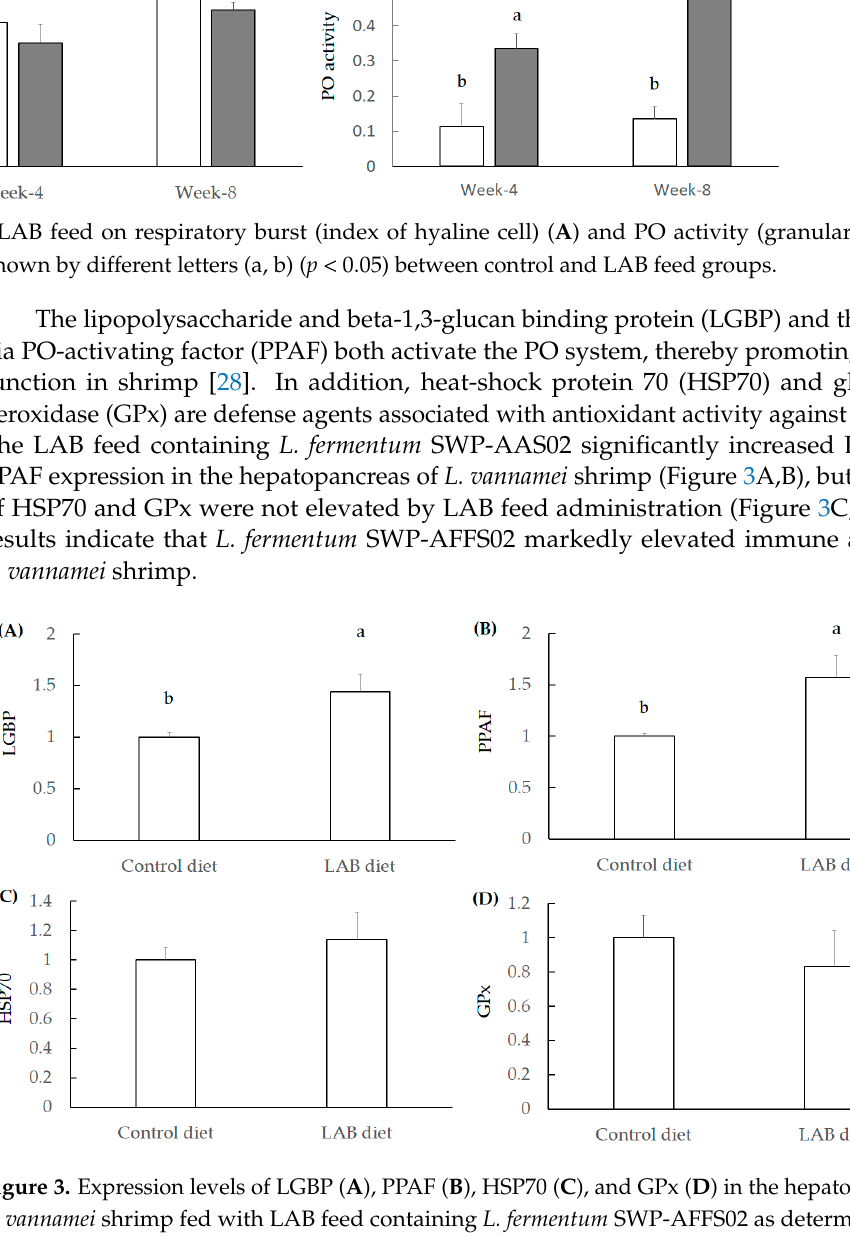
Figure 4. Alpha and Beta diversity of intestinal microbiota in L. vannamei shrimp. ( A ) Venn diagram. The overlapping part indicates the number of OTUs shared between control and LAB treatment groups, and the non-overlapping part indicates the number of unique OTUs between two groups. ( B ) Principal component analysis (PCA) for species. Each point in the figure represents one sample, and the same grouped samples are represented by the same color. We analyzed the most abundant microbes (top 35) at the genus and family levels in the stool of L. vannamei shrimp fed a control feed or a LAB feed. The results indicated that Pseudomonas , Bacillus , Idiomarina , NS5_marine_group, Aliidiomarina , and Alcanivorax at genus level (Figure 5A) and Flavobacteriaceae , Pseudomonadaceae , Bacillaceae , Idiomarinaceae , Rhodobacteraceae , Legionellaceae , Halieaceae , Alcanivoracaceae , Paenibacillaceae , Halomona- daceae , and Shingomonadaceae at family level (Figure 5B) in seawater were higher than in the stool of L. vannamei shrimp fed with control or LAB feed; however, other bacteria in seawater were markedly lower than those in the stool of L. vannamei shrimp, suggesting that some mechanisms may regulate special microbes remaining in the shrimp intestine,